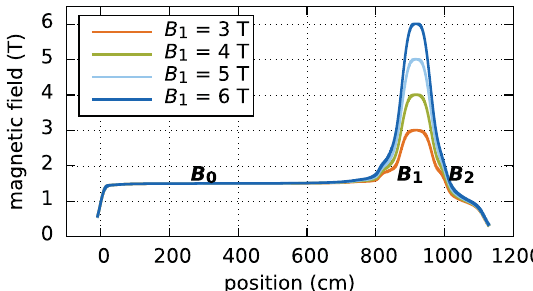
Figure 4. Magnetic field strength B along the center and edges of the e − / p + -beam from the decay volume in the neutron guide to the selector for B 1 =